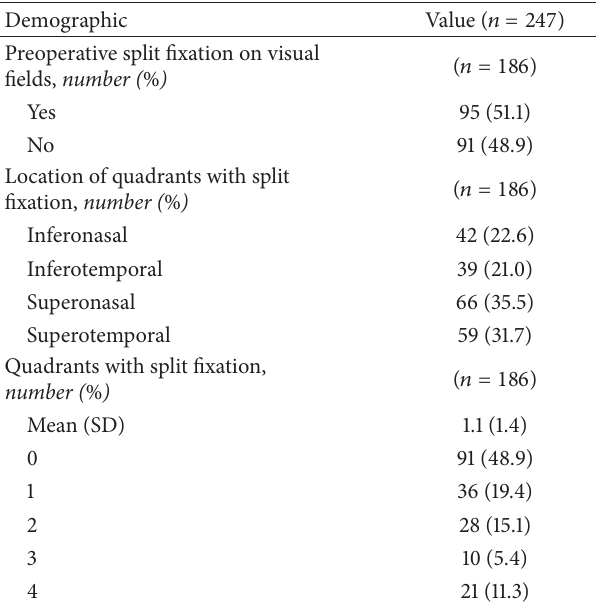
Table 1: Baseline preoperative demographics of 222 patients under- going Baerveldt glaucoma tube shunt implantation in 247